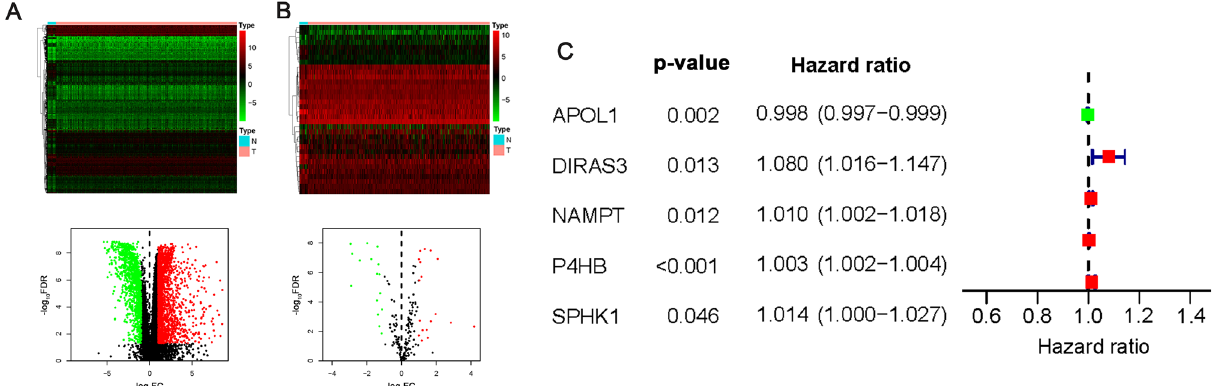
Figure 2. Identification of BLCA specific DEGs, DEARGs, and PDEARGs. ( A ) Heat map and volcano plot of DEGs. ( B ) Heat map and volcano plot of DEARGs. The green to red spectrum indicates low to high gene expression in the heat map; the red, green and black dots represent upregulated, downregulated and unchanged genes in the volcano plot, respectively. ( C ) Forest graph of PDEARGs. The red and green dots represent PDEARGs with a hazard ratio > 1 and ≤ 1,